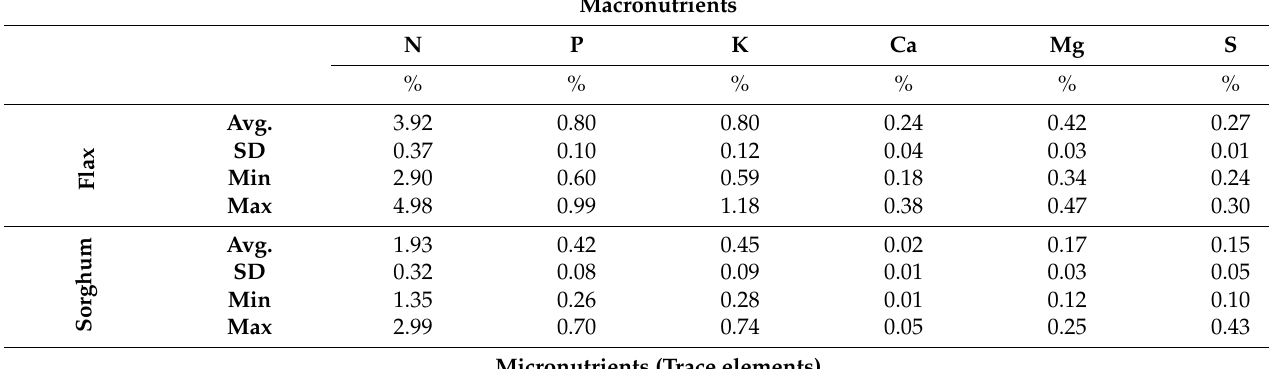
Table 4. Descriptive statistics in seed ionomic concentrations of 102 diverse flax genotypes and 108 sorghum genotypes. SD, standard deviation. Each value is the mean of three replicates.